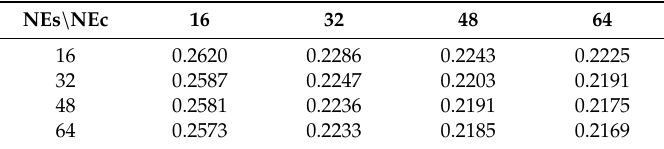
Table 1. Convergence of η for ∆ t = T